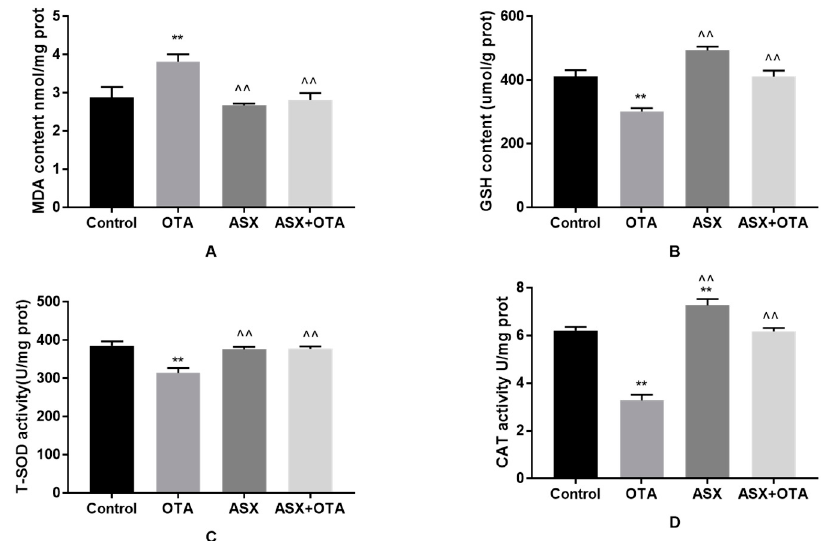
Figure 5. Antioxidant status. The contents of malondialdehyde (MDA) ( A ) and glutathione (GSH) ( B ), and the total superoxide dismutase (T-SOD) ( C ) and catalase (CAT) ( D ) levers in the renal tissue in the four groups. Values represent the mean ± the standard deviation (SD). group. n = 7 mice/group. ˆ p < 0.05, ˆˆ p < 0.01 vs. the OTA group; * p < 0.05, ** p < 0.01 vs. the control group.